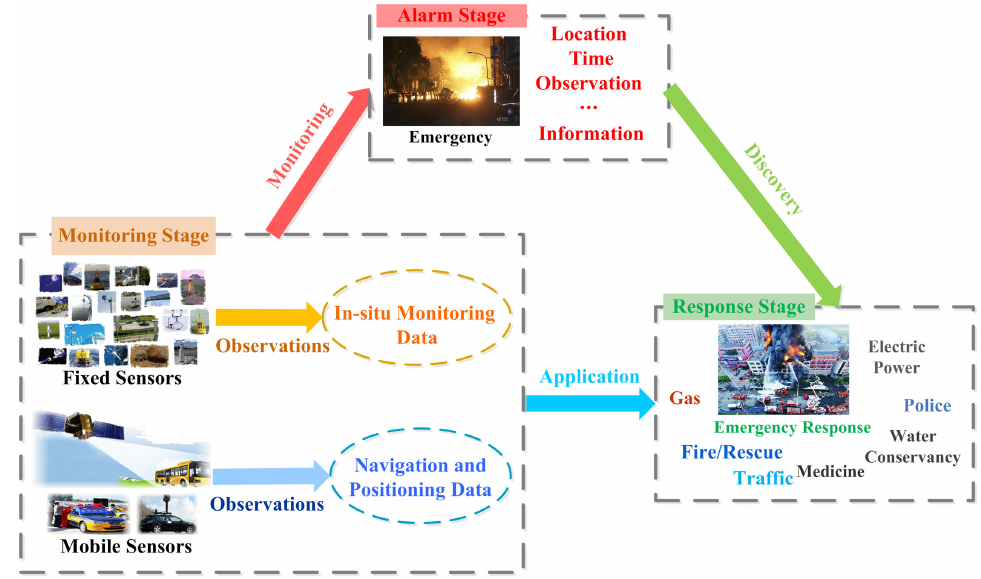
Figure 1. Data classification and association of interdisciplinary instant point observations.